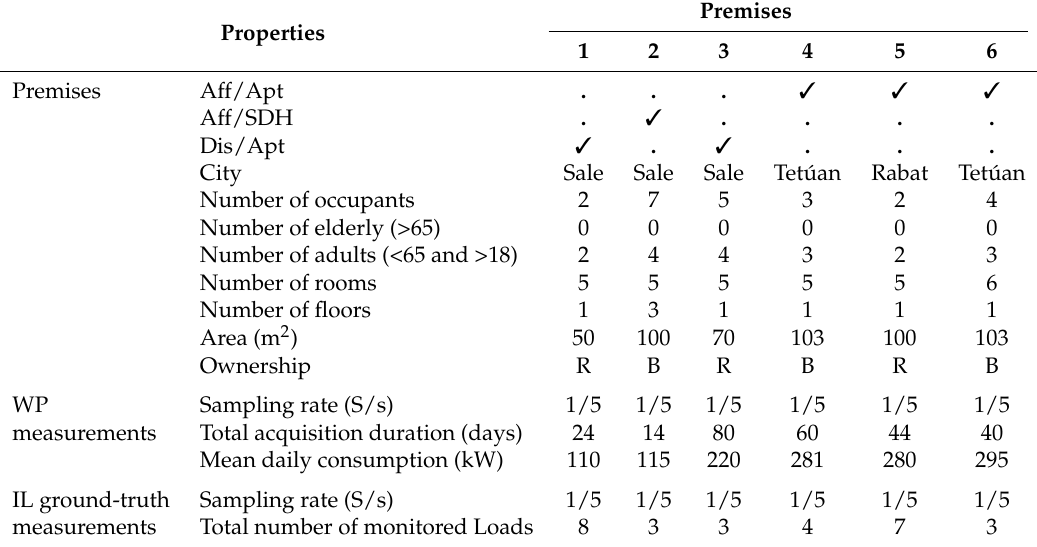
Table 3. Summary of households monitored for WP and IL ground-truth consumption data in MORED. Aff/Apt: affluent neighborhood apartment; Aff/SDH: affluent neighborhood semi-detached house; Dis/Apt: disadvantaged neighborhood apartment; R: rented; B: bought.